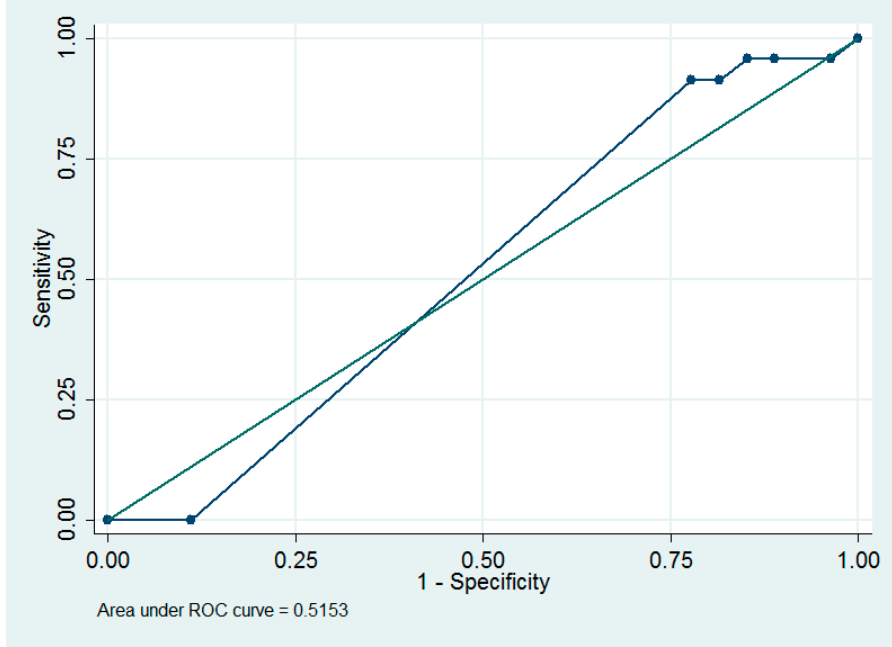
Figure 2. The receiver operating characteristic curve for the number of IP or dose-dense chemotherapy cycles as a predictor of death.